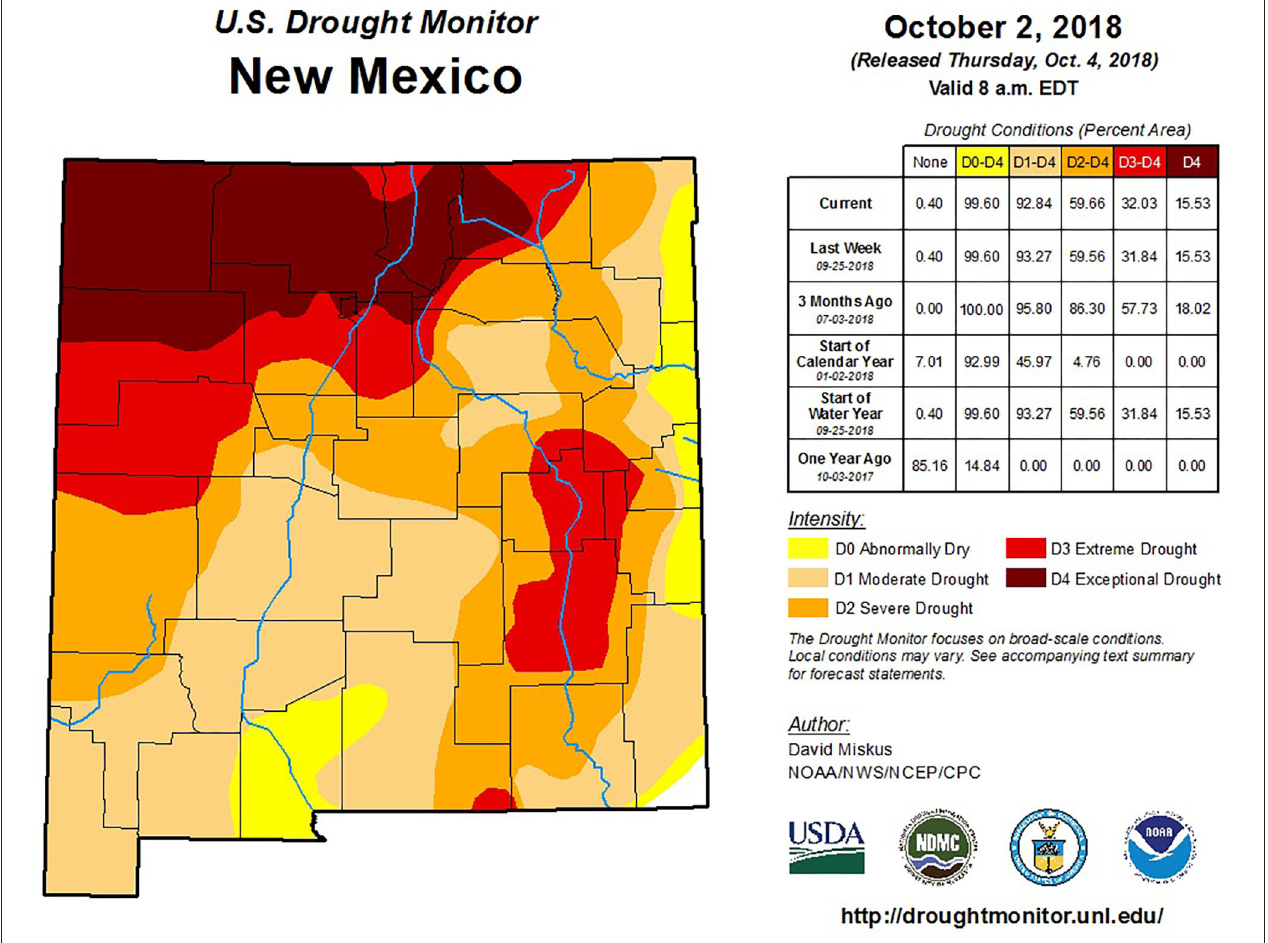
FIGURE 2 | A USDM map of New Mexico for 2 October 2018 and an associated table with relevant statistics comparing the drought coverage with other past time periods ( NDMC, 2020).